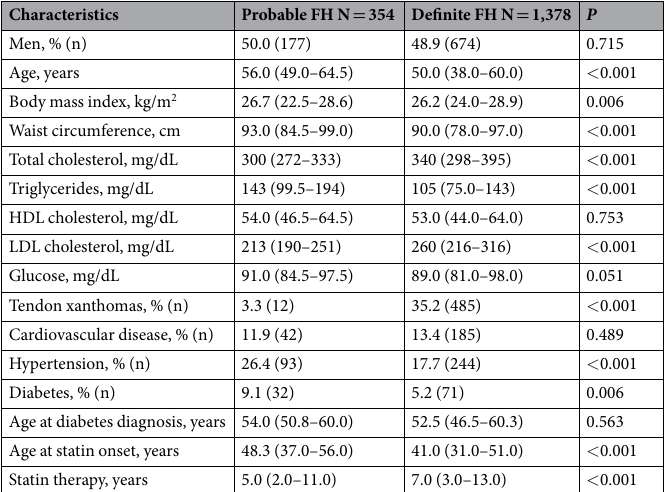
Table 1. Demographic and clinical characteristics of heterozygous familial hypercholesterolemia patients. Values are expressed as median (interquartile range) for continuous variables and percentage (n) for categorical variables. HDL denotes high-density lipoprotein; LDL, low-density